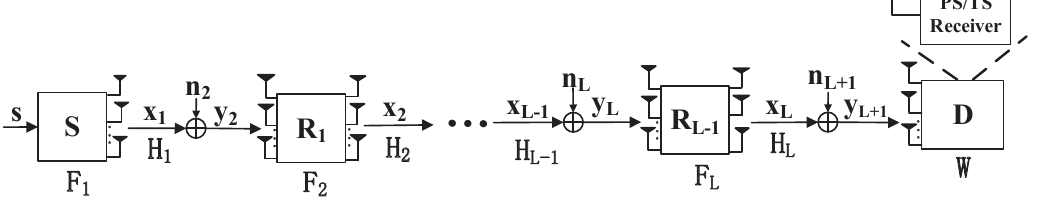
Figure 1. A multi-hop MIMO system with power splitting or time switching